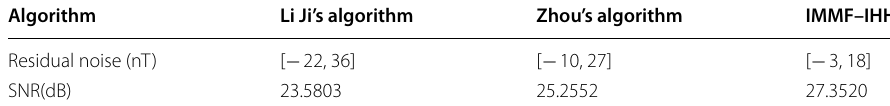
Table 5 Residual noise range and SNR of three algorithm